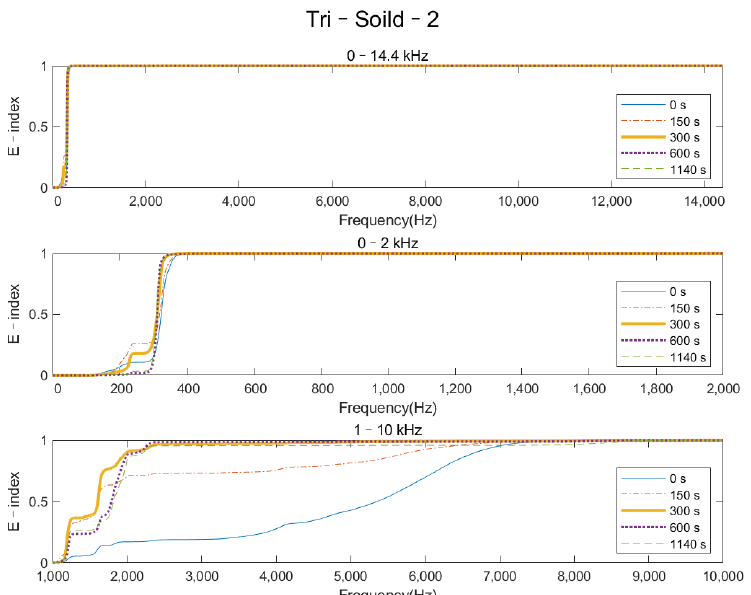
Figure 9. Plots of the normalized magnitude development as the function of cure time for triangular implants with a hollow IM stem.